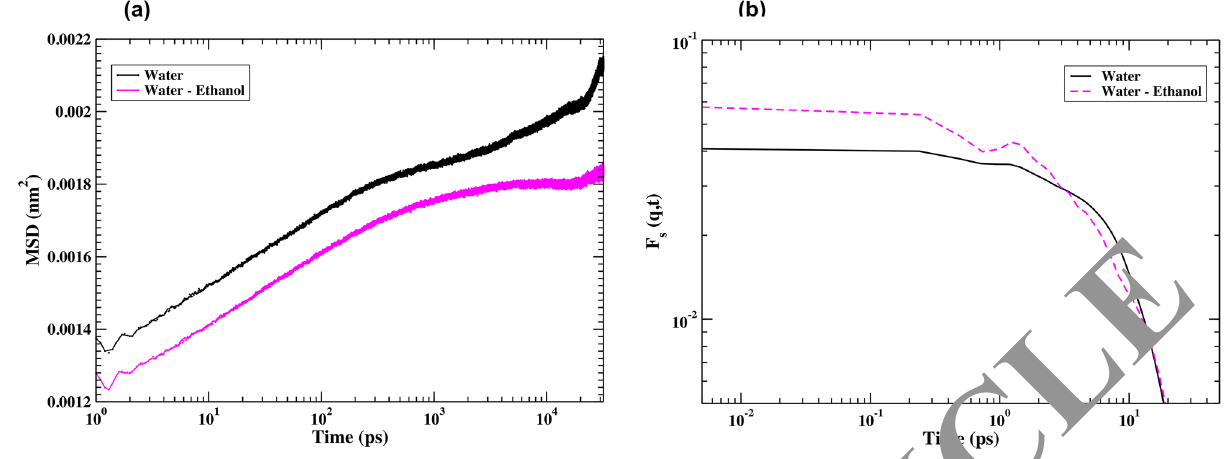
Figure 4. ( a ) The calculated MSD of IFN - γ in water (black) and in the water–ethanol mixed solvent (magenta) from the MD simulation. ( b ) The calculated self ISF of IFN - γ in water (black) and in the mixed ethanol–water solvent (magenta) from the MD